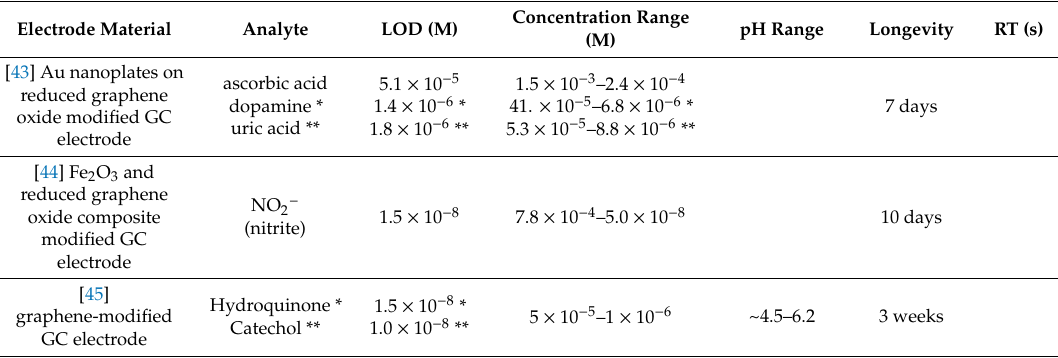
Table 2. Carbon-based electrodes and their